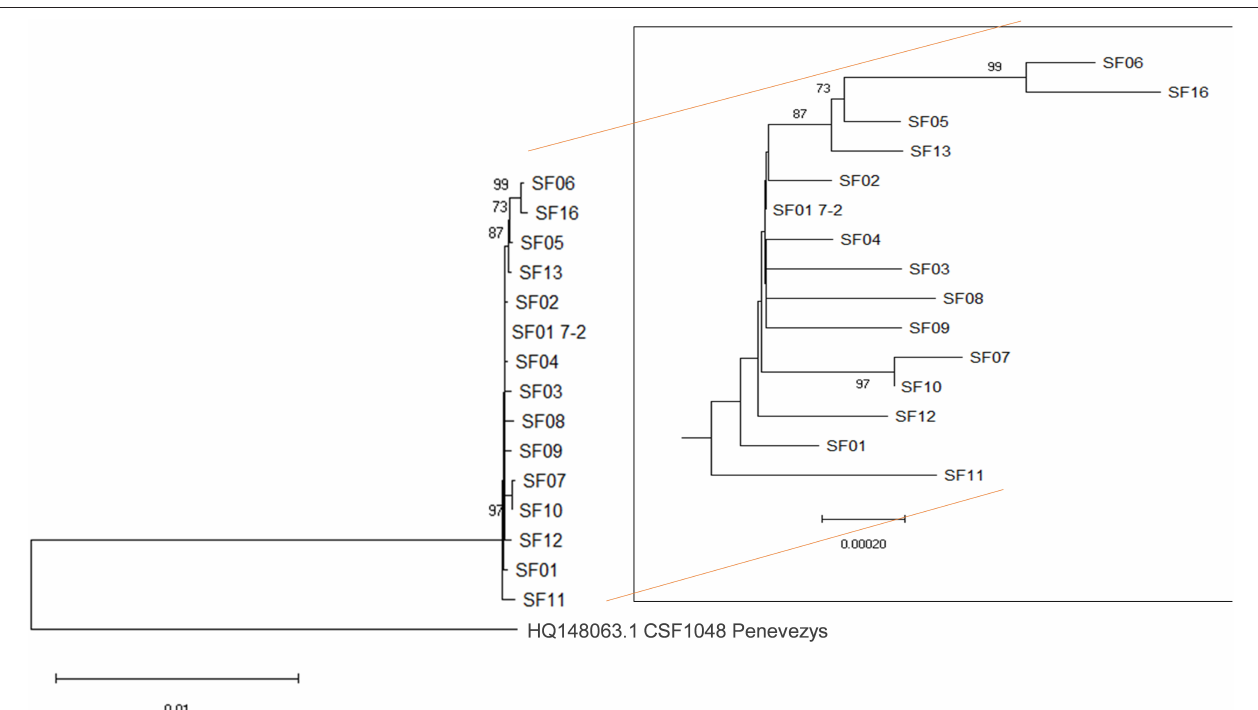
FIGURE 2 | Phylogenetic analysis. Almost full-length sequences from 14 infected premises were aligned using the sequence of the closely related genotype 2.1 CSFV1048 Penevezys sequence as an outgroup. There were a total of 12,136 positions in the final dataset. The percentage of replicate trees in which the associated taxa clustered together in the bootstrap test (1,000 replicates), is shown next to the branches with values ≥ 70%. SF01 7-2 is a sequence from a pooled sample from the first premise on which CSF was confirmed, whereas SF01 is from a single animal from the same